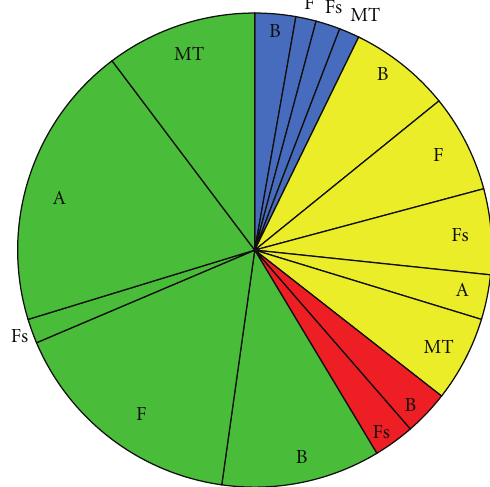
Figure 7: Pie chart representing the proportion of impacts for each ecosystem component for Impact scenario i6, wave energy project, categorized by whether the e ff ect is positive (blue), minor negative (green), moderate negative (yellow), or major negative (red). B = Benthic habitat and resources; F = Fish; Fs = Fisheries; A = Avian species; MT = Marine mammals and sea turtles.